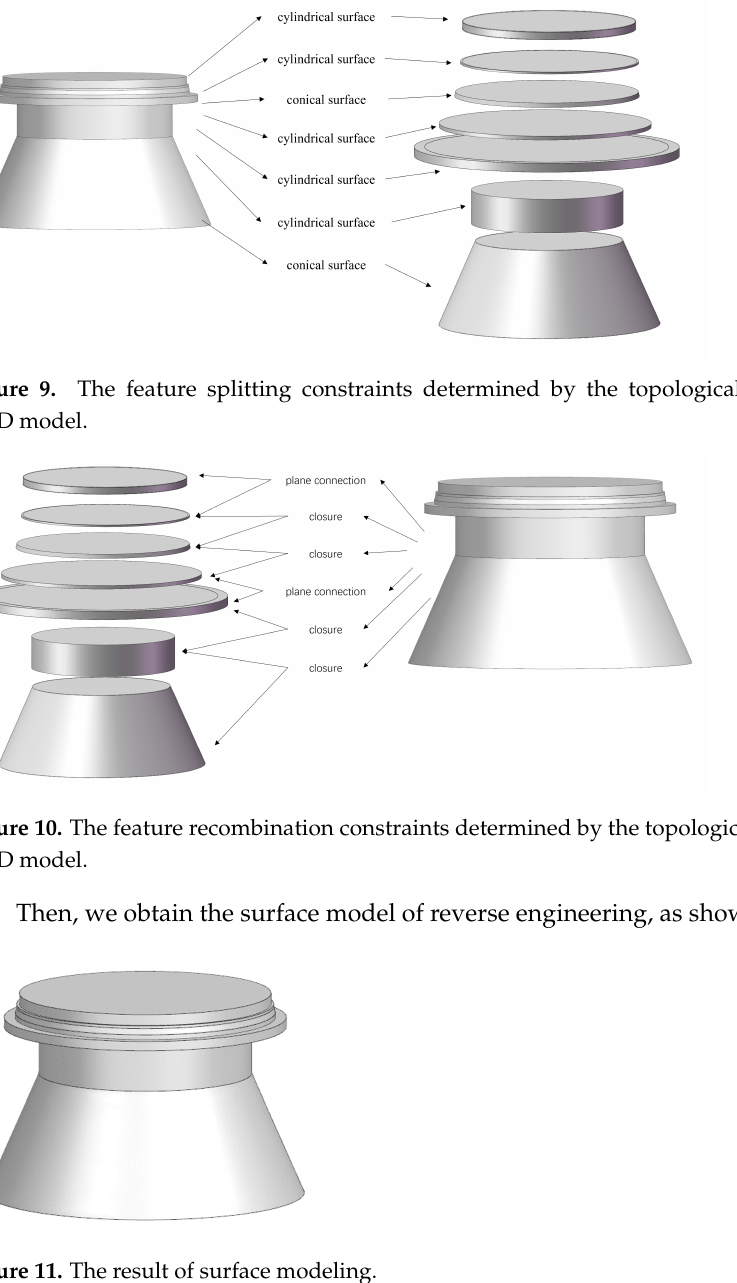
Figure 11. The result of surface